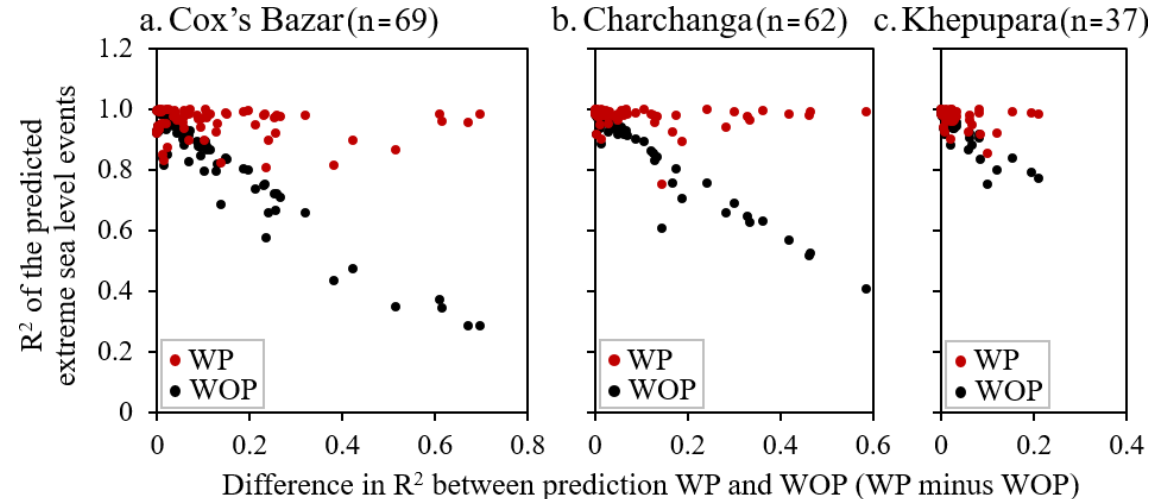
Figure 8. The relationship between the R 2 values of sea level predictions based on MLR for WP and WOP at ( a ) Cox’s Bazar, ( b ) Charchanga, and ( c ) Khepupara. Each dot corresponds to an ESL event. Red and black dots represent R 2 for predictions WP and WOP, respectively. The y-axis represents the R 2 for predictions WP. The x-axis represents the differences in R 2 between WP and WOP predictions. Table 1. The evaluation of the root mean square error (RMSE) for prediction with precipitation (WP) and without precipitation (WOP).